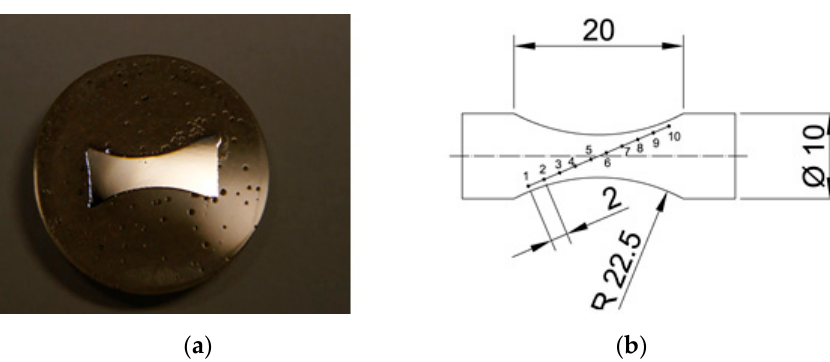
Figure 21. ( a ) The sample for monitoring the microstructure of the welded joint; and ( b ) the schematically described position of the measurement of micro-hardness HVM corresponding with Table 2.